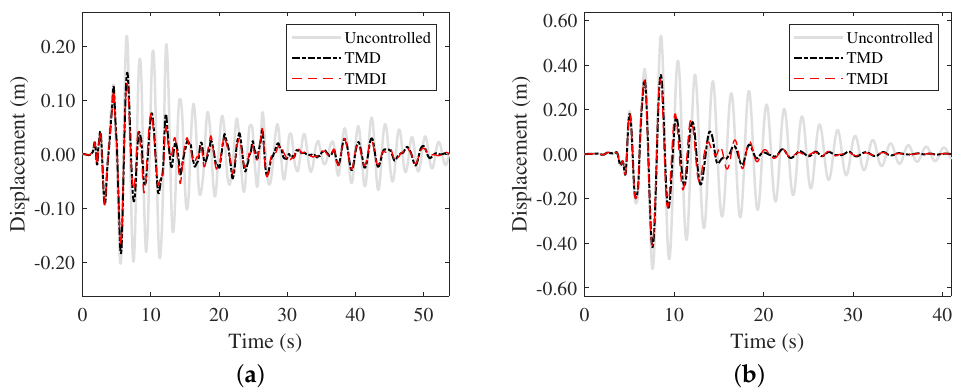
Figure 8. The relative displacement of the primary structure under earthquake: ( a ) EL Centro and ( b ) Kobe.